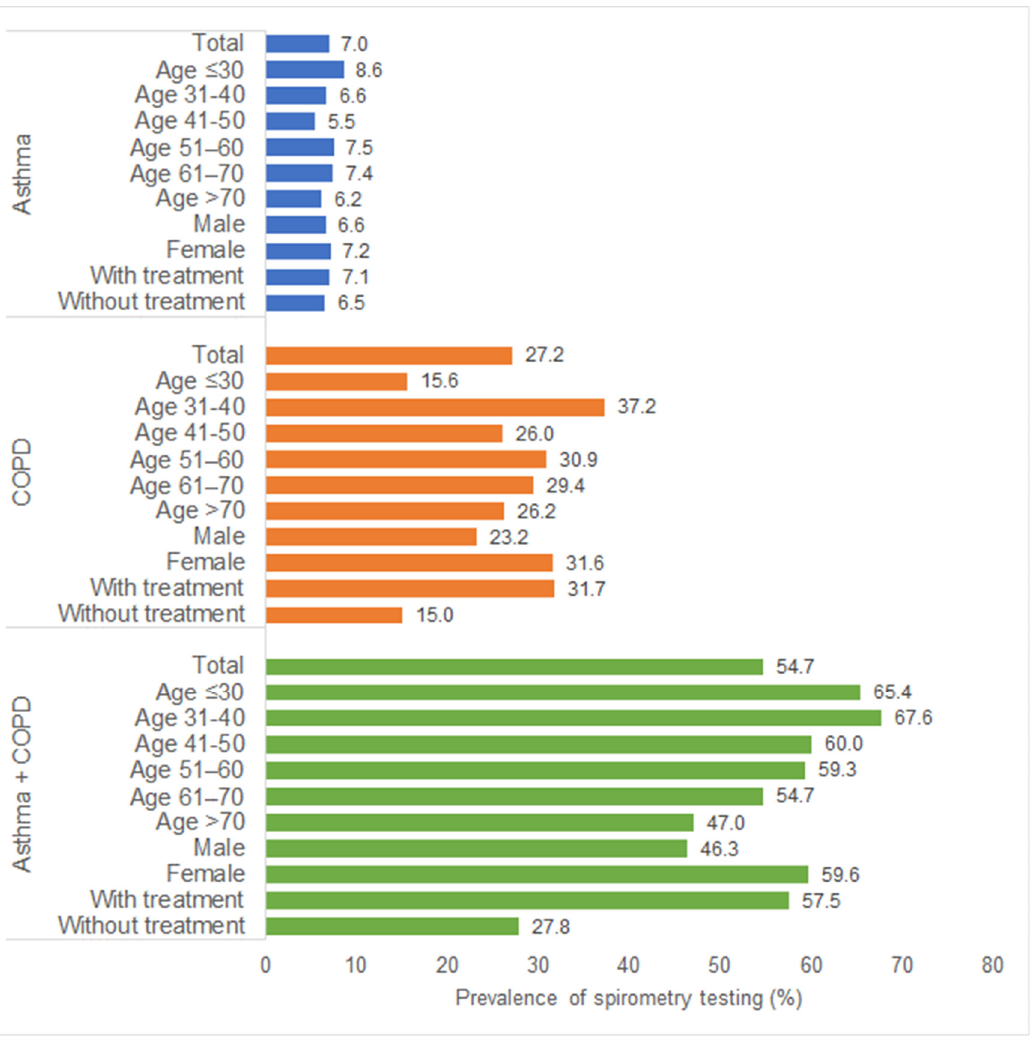
Figure 1. Prevalence of spirometry testing among asthma and COPD patients in general practices in Germany. Table 1. Age and sex characteristics of asthma and COPD patients with and without spirometry